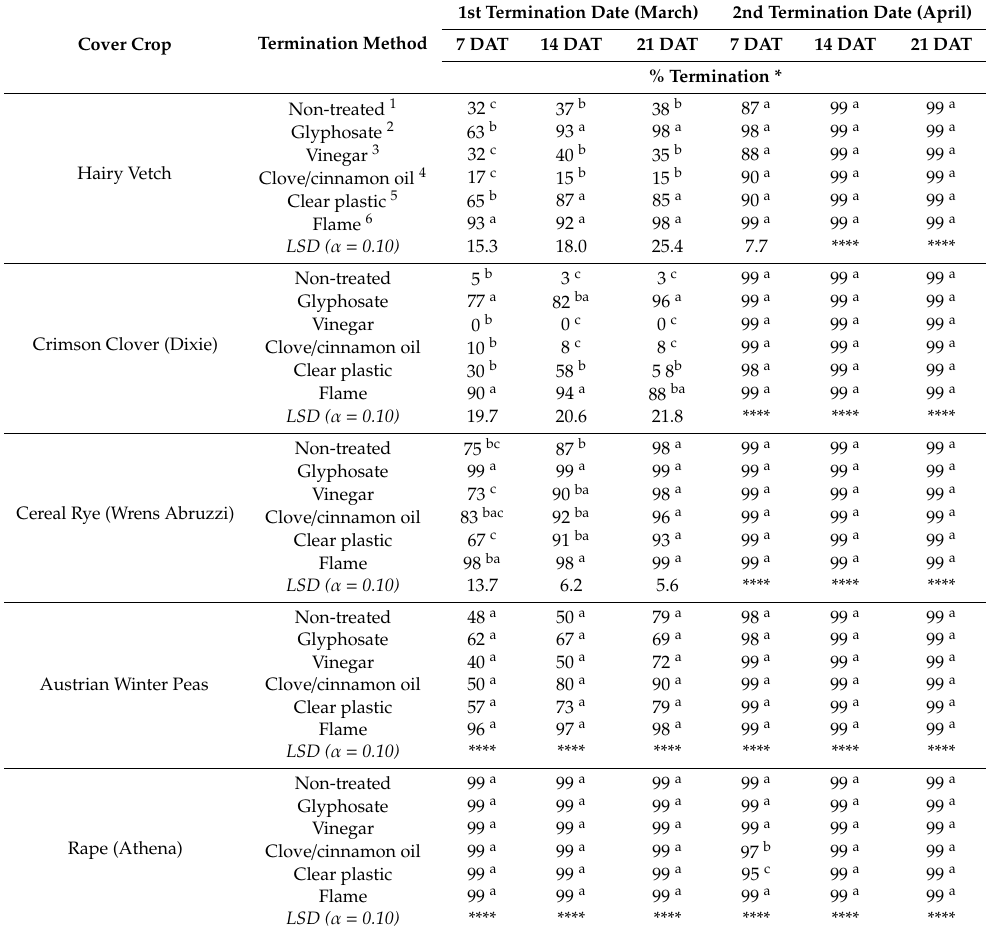
Table 4. Cover crop response to termination method by termination date in